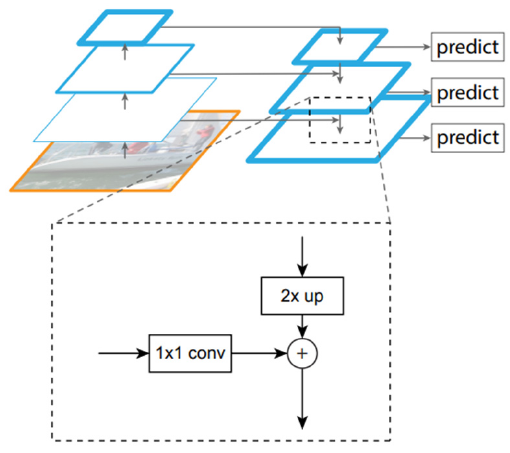
Figure 4. The structure of the feature pyramid network; ♁ is the elementwise sum.